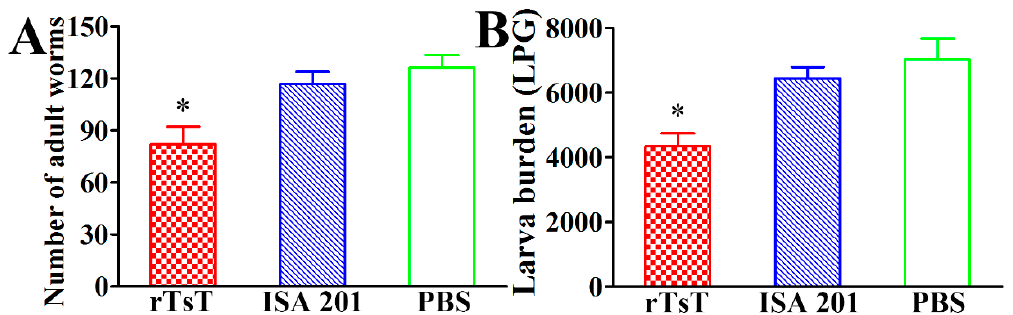
Figure 13. Immune protection induced by rTsT immunization after challenge with 300 T. spiralis larvae. ( A ): Intestinal AW burden at 5 days after challenge; ( B ): Muscle larval burden (larvae per gram of skeletal muscle tissue, LPG) at 30 days after challenge. The parasite burdens are shown as the mean ± SD for 10 mice per group. * p < 0.01 compared to the ISA 201 and PBS groups.